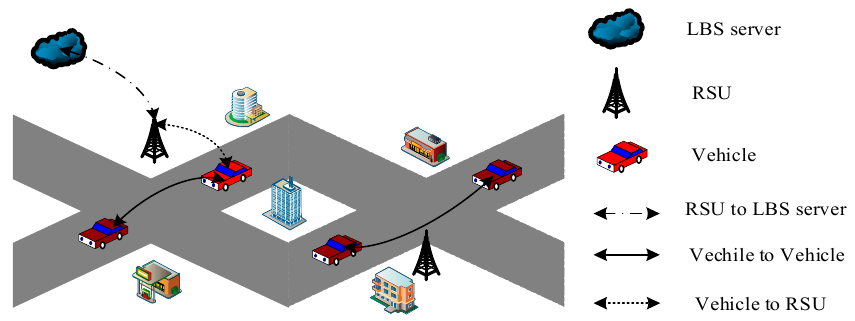
Figure 1. The system architecture of IoV.